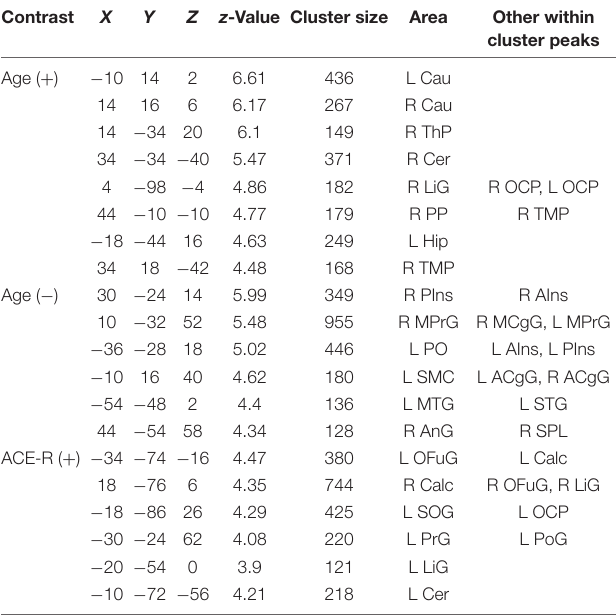
TABLE 2 | Regions showing significant (FWEc p < 0.05, CDT p = 0.001) relationship between whole-brain ICC values and age and ACE-R total score. Contrast Other within